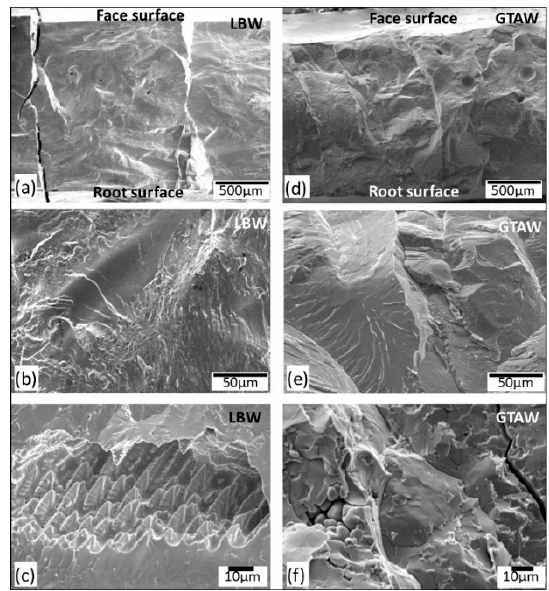
Figure 12. SEM images showing the fracture surface of ( a – c ) LBW and ( d – f ) GTAW samples. Gas pores are visible on ( d ); an extensive cleavage fracture is shown in ( e , f ); porosities due to incomplete solidification are evident in ( c , f ).